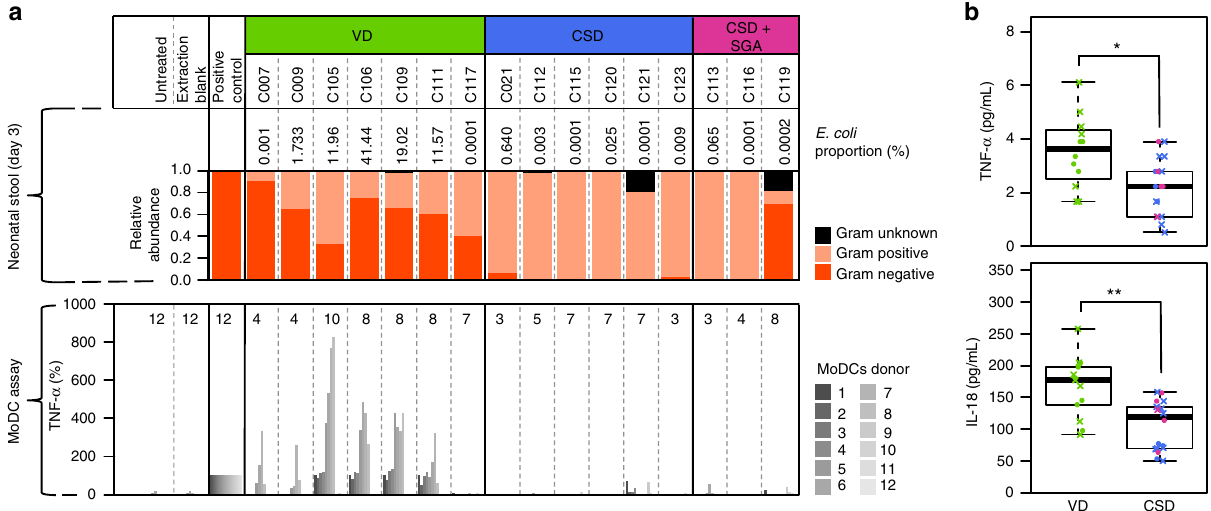
Fig. 4 Cytokines of monocyte-derived dendritic cells after stimulation with LPS from neonatal stool and in neonatal plasma. a Lipopolysaccharide (LPS) was isolated from faecal samples collected on day 3 postpartum from neonates in groups of vaginal delivery (VD), caesarean section delivery (CSD) and CSD with small for gestational age (SGA) status (CSD + SGA), and incubated for 24 h with human monocyte-derived dendritic cells (MoDCs) isolated from a total of 12 adult donors. MoDCs were stimulated with the exact same LPS volume that was extractable from the same initial amount of faecal material from each neonate sample (Methods). Exact numbers of donors used per sample are given in the plot. Positive control: LPS isolated from E. coli overnight culture. Neonates C115 and C116 are twins. b Plasma levels of TNF- α and IL-18 in samples collected at day 3 after birth from VD and CSD (±SGA) neonates. Comparison by Wilcoxon rank-sum test with multiple testing adjustment; *false discovery rate (FDR)-adjusted P < 0.05 and **FDR-adjusted P < 0.01. Circles correspond to neonates with metagenomic data, crosses represent neonates without metagenomic data. Boxplots: centre line – median, bounds – fi rst and third quartile, whiskers < = 1.5 × interquartile